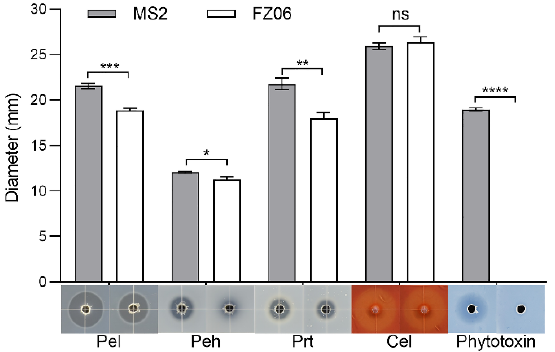
Figure 1. Plant-cell-wall-degrading enzymes (PCWDEs) and phytotoxins produced by strains FZ06 and MS2. Twenty microliters of MS2 or FZ06 culture (OD 600 of 1.5 in LB medium) was added into each well (5 mm in diameter) of the assay plates and incubated at 28 °C until photographed. The diameter of transparent and antagonistic halos was measured. GraphPad Prism 8.4.1 was used to perform unpaired two-tailed t -tests, and the data of strain FZ06 were compared with those of strain MS2. The data present the means of three replicates, and error bars represent the standard deviation. “ns” indicates not significant, * indicates p < 0.05, ** indicates p < 0.01, *** indicates p < 0.001, and **** indicates p < 0.0001.